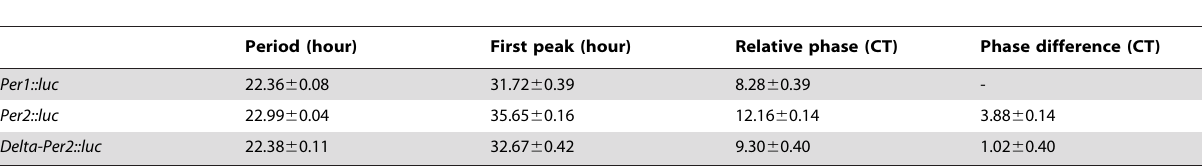
Table 1. Oscillatory period, phase, and phase difference of promoter driving luciferase